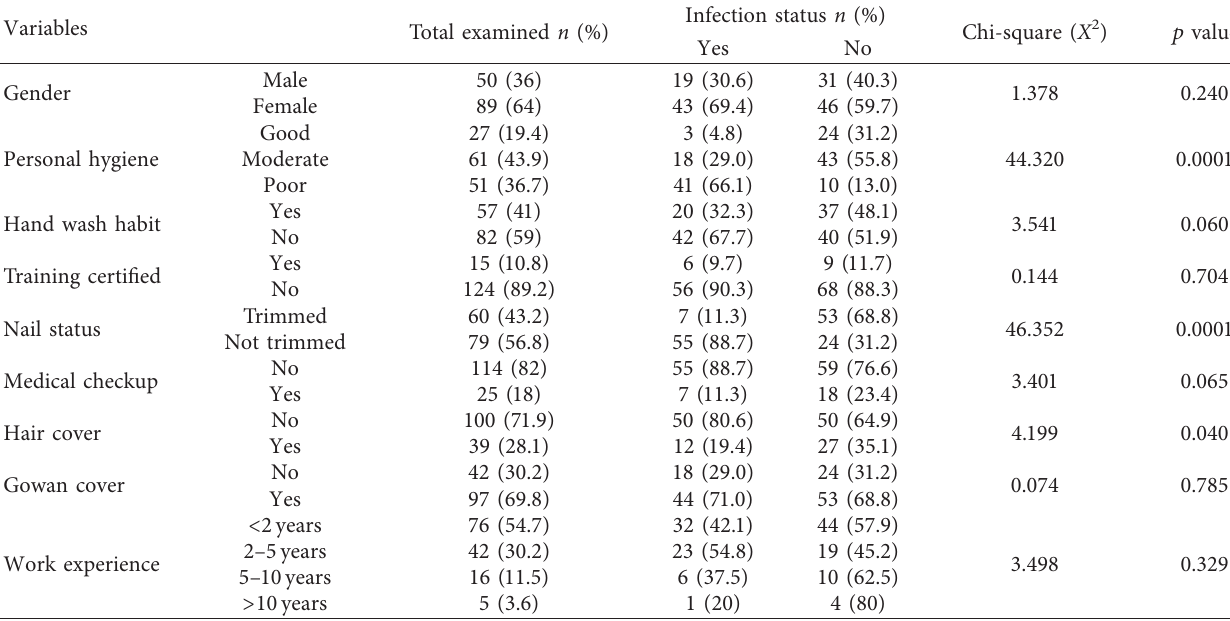
Table 1: Sociodemographic characteristics with respect to prevalence of intestinal parasites among food handlers in food establishment areas of Mettu town.